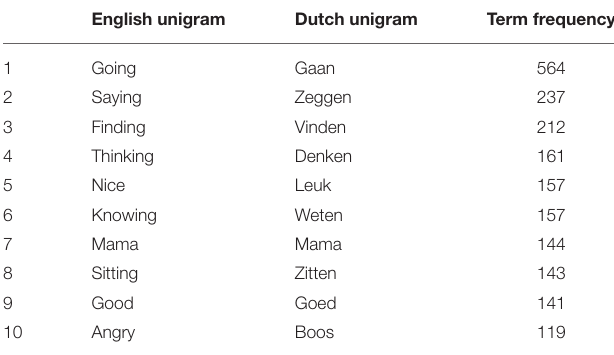
TABLE 4 | Ten most frequent unigrams from the terms selected for the LDA model.